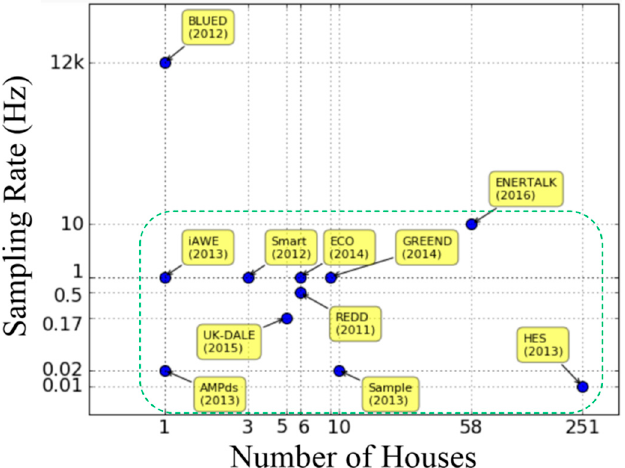
Figure 2. Summary of publicly available NILM datasets and the ENERTALK dataset used in this study. Datasets within the green box are the ones that require the lowest level of cost for hardware. Some of the datasets partly contain aggregate data with higher sampling rates, but only those sampling rates that are used for the supervised NILM tasks have been shown.